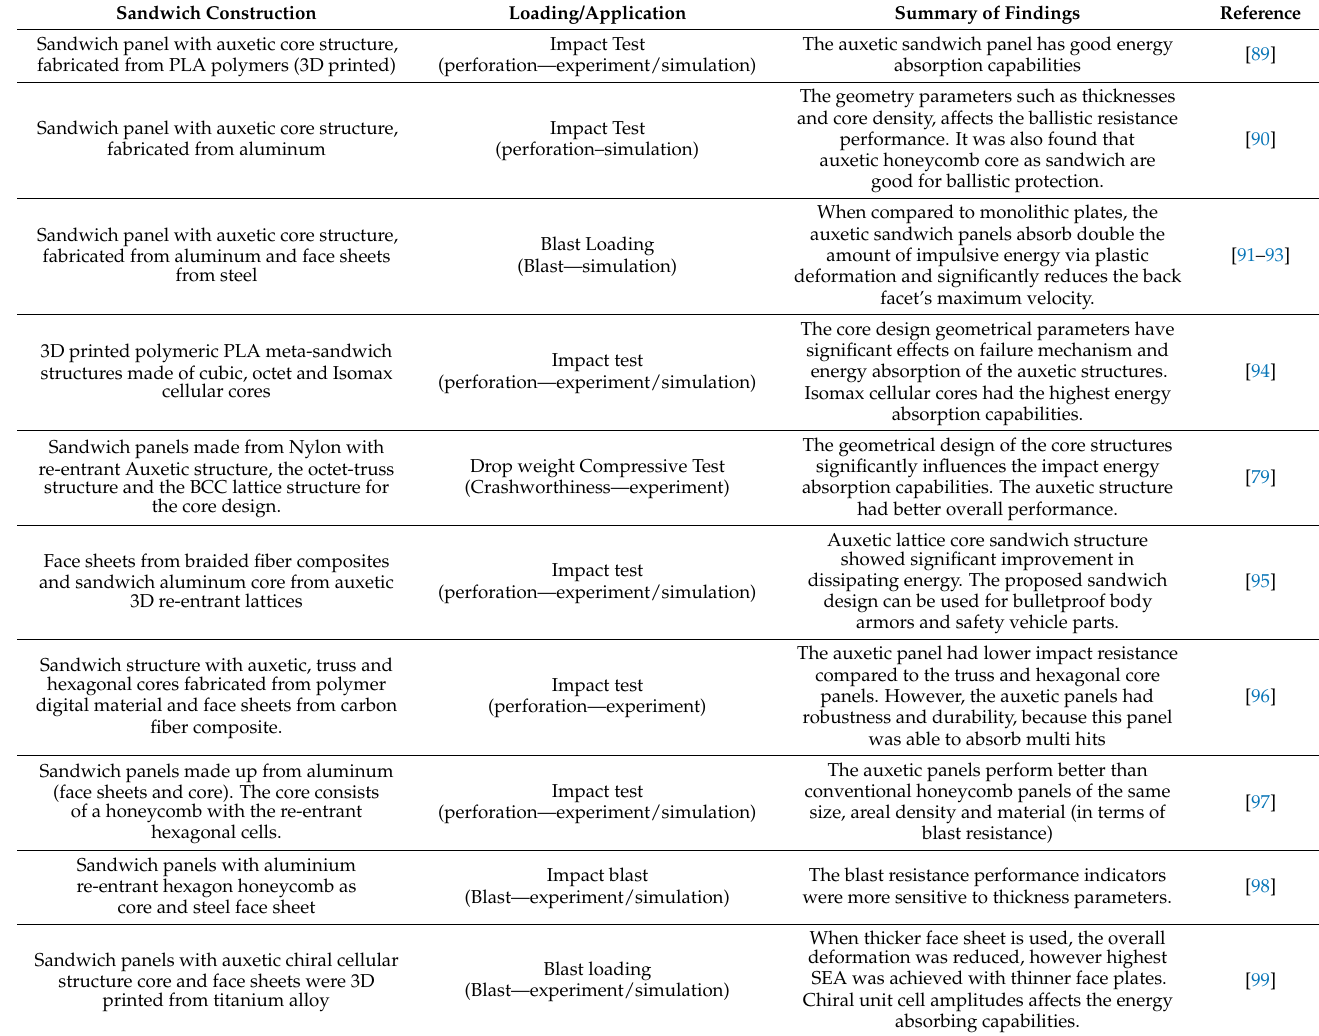
Figure 6. Example of auxetic structure that can be used to construct the core of a sandwich panel. (image source: “Creative Commons Multifunctional classification and representative structures of periodic chiral structures” by Kelkar et al. https://doi.org/10.3390/s20113132 (accessed on 18 August 2021), used under CC BY 4.0). Table 6. Sandwich structure with auxetic